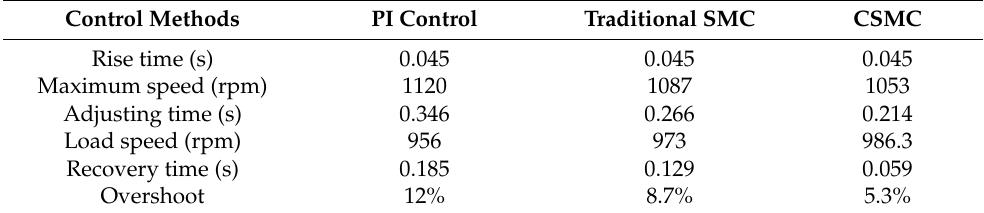
Table 6. Experimental speed changes and adjustment time under load mutation.